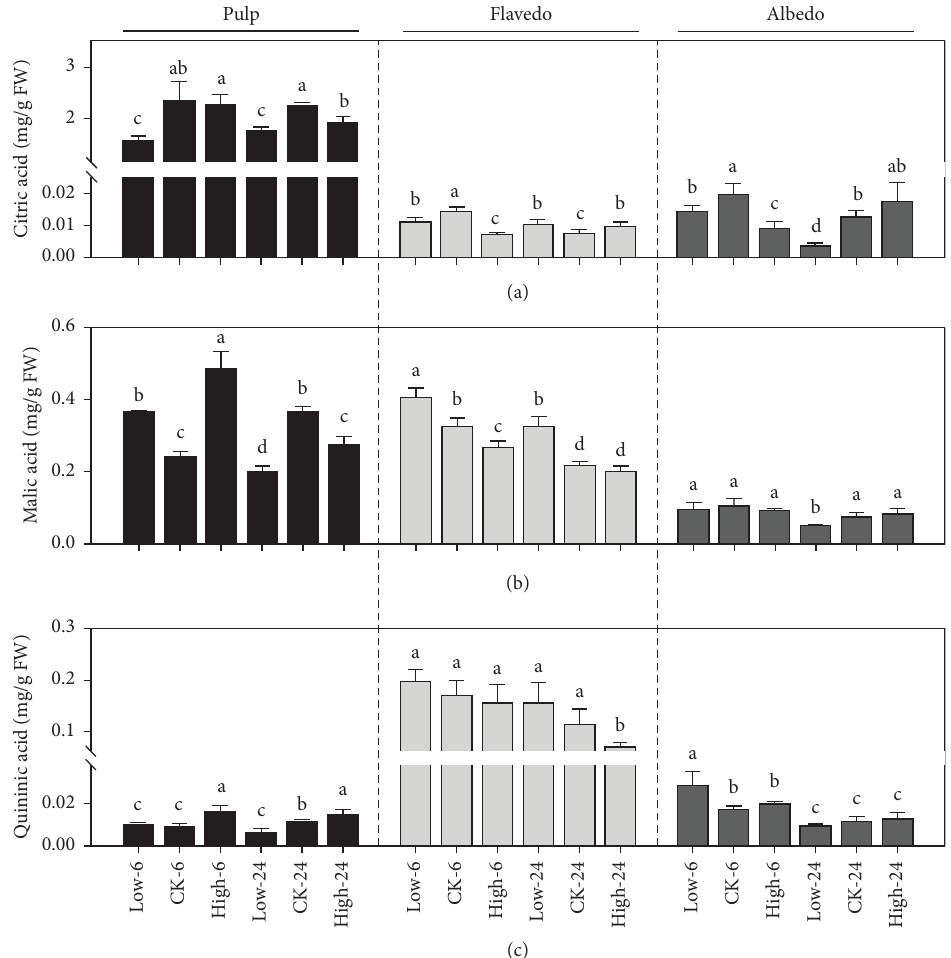
Figure 3: Efects of short-term temperature treatments on the organic acid contents ((a) citric acid; (b) malic acid; and (c) quininic acid) in the pulp, favedo, and albedo of Valencia orange fruits. Te vertical bars represent the standard errors of the mean. Values with diferent letters within the same fgure are signifcantly diferent according to the ANOVA test at p < 0 .